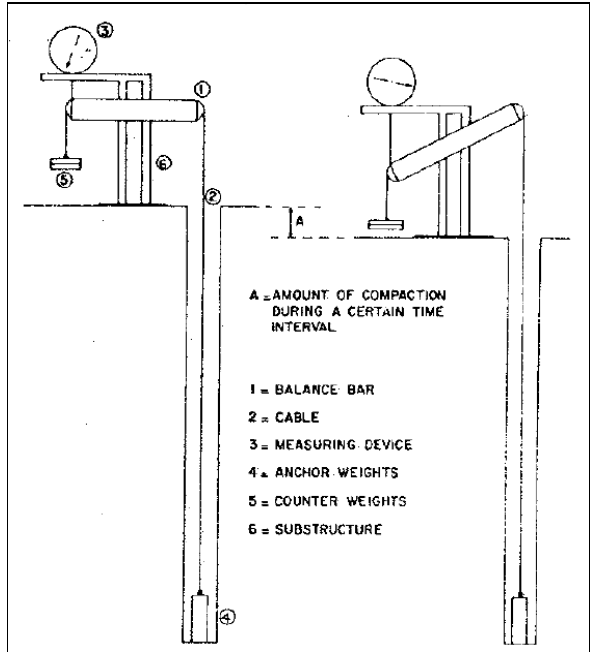
Figure 1. Assestimeter, Cable-measurement method Piezometer instead is used to measure: 1. static liquid pressure in a system by measuring height to which a column of the liquid rises against gravity 2. the static pressure (piezometric head) of groundwater at a specific point A scheme of a piezometer is shown in Figure 2. Pressure can be read manually or automatically, by using electrical pressure transducers.